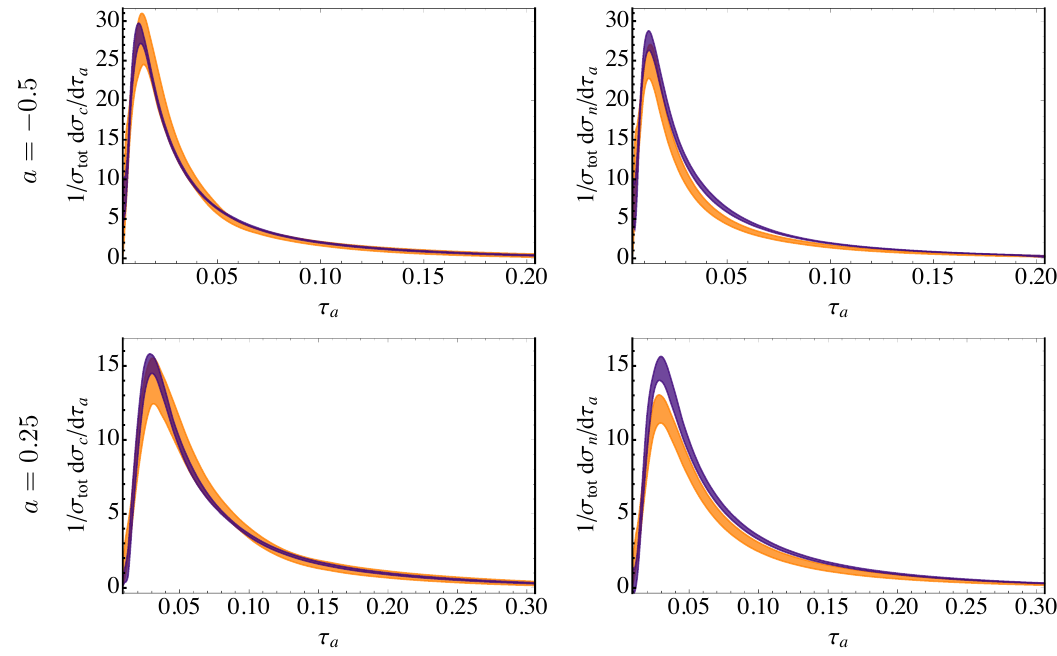
0 : 5 and a = 0 : 25 at Q = m Z over the (cid:0) ( (cid:11) s ) (orange) and NNLL 0 + ( (cid:11) 2 ) s O O